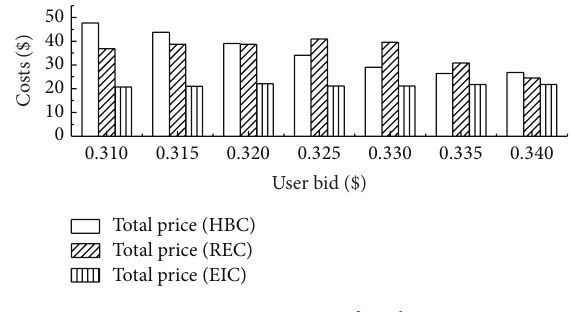
Figure 16: Comparison of total costs.